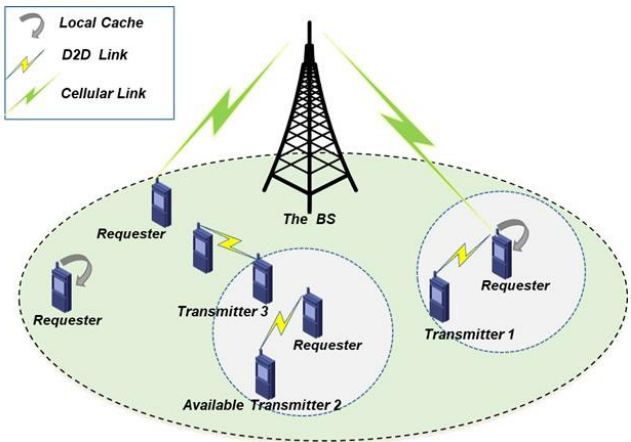
Figure 1. Illustration of system model.